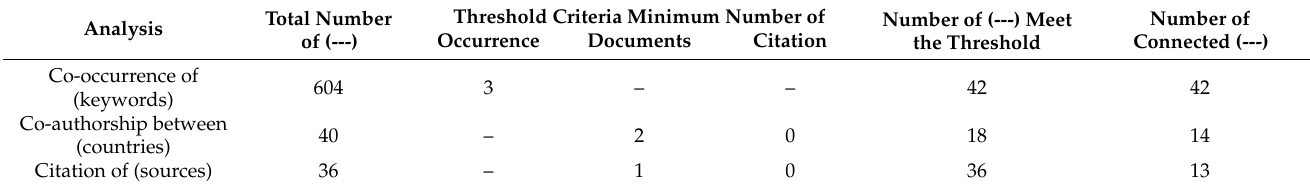
Table 1. Summary of results of some selected scientometric